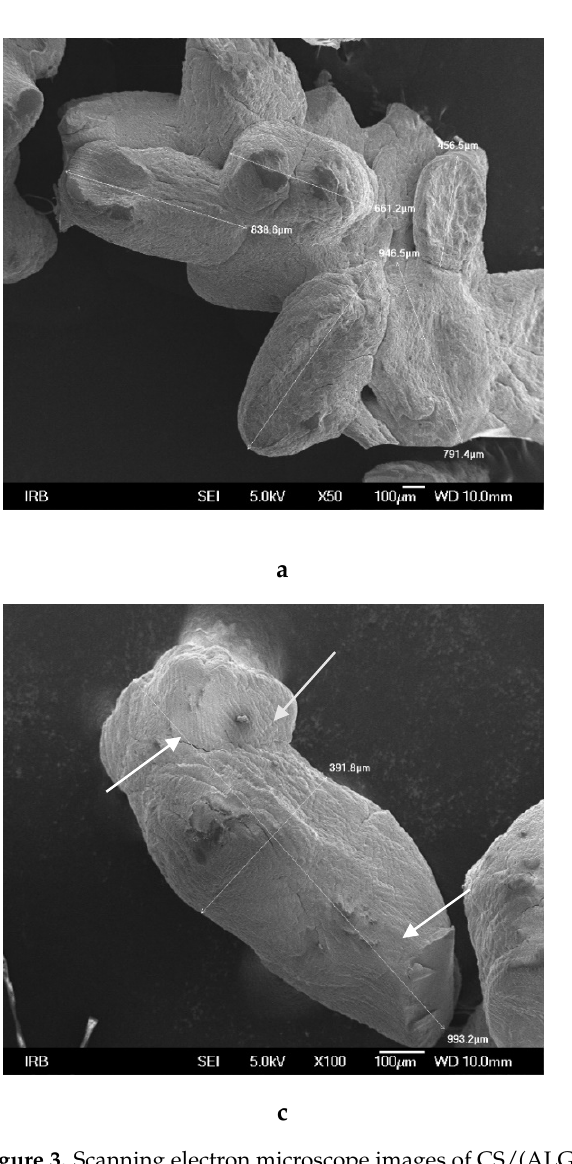
Figure 3. Scanning electron microscope images of CS/(ALG/Ca) ( a , b ) and CS/(ALG/Ca+Cu)) ( c , d ) dried microcapsules. Bars are indicated.